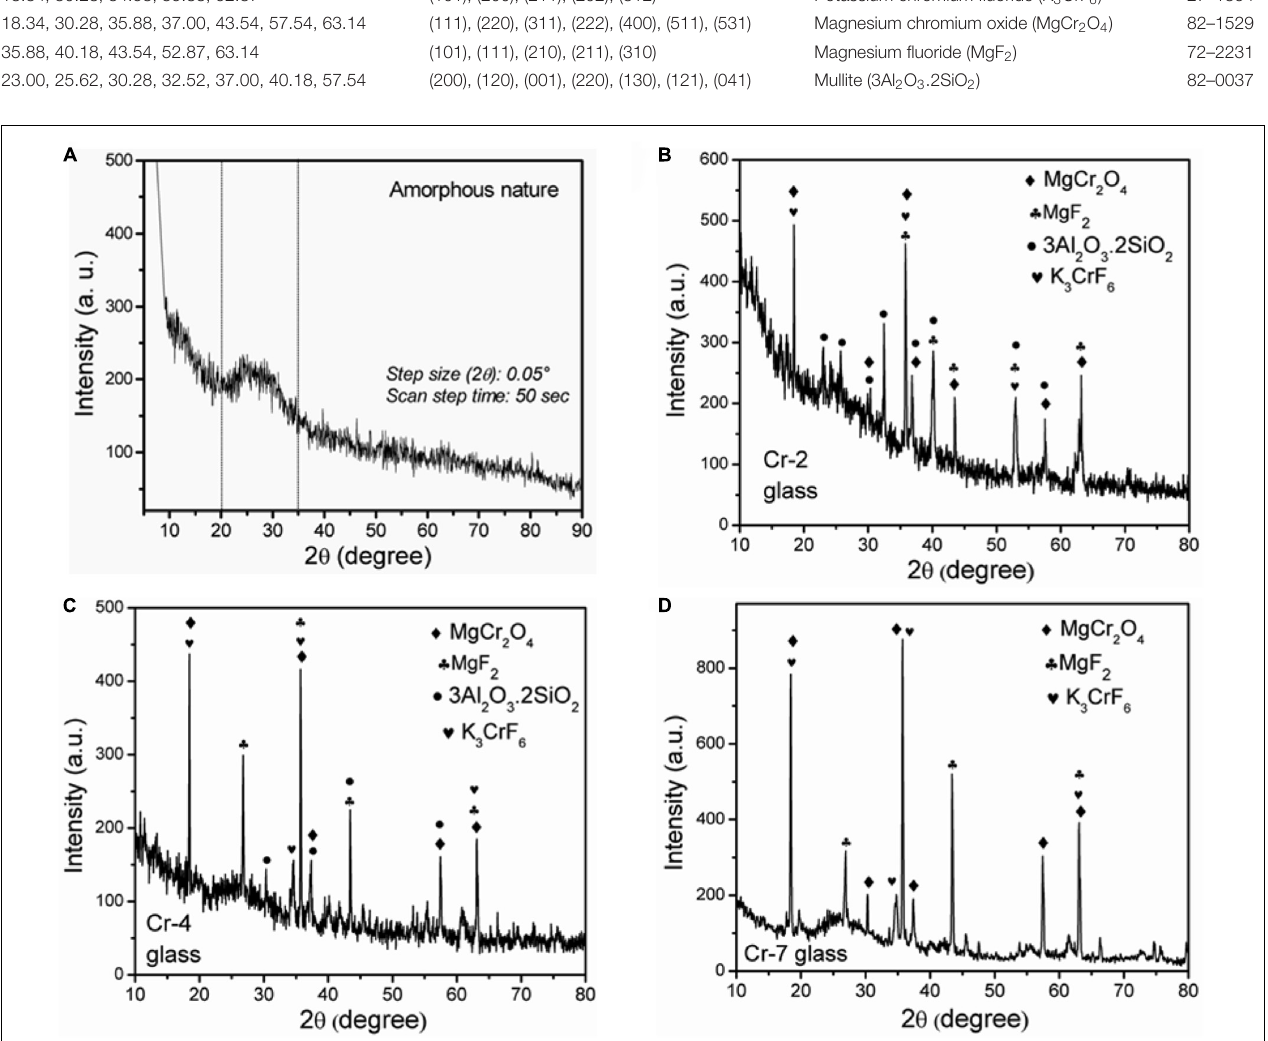
FIGURE 4 | XRD pattern of K 2 O-MgO-Al 2 O 3 -B 2 O 3 -SiO 2 -F glasses containing (A) 0 mol%, (B) 2 mol%, (C) 4 mol%, and (D) 7 mol% K 2 Cr 2 O 7 content, demonstrating the crystalline nature with the development of MgCr 2 O 4 , MgF 2 , K3CrF 6 , and mullite crystalline phases (for composition see Table 1